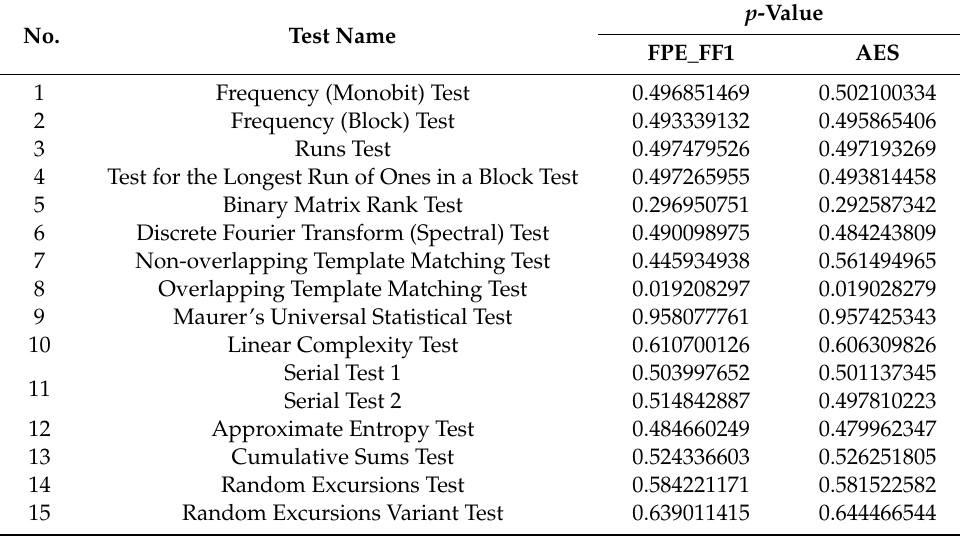
Table 5. The p -value of the National Institute of Standards and Technology (NIST) 800-32 test results.